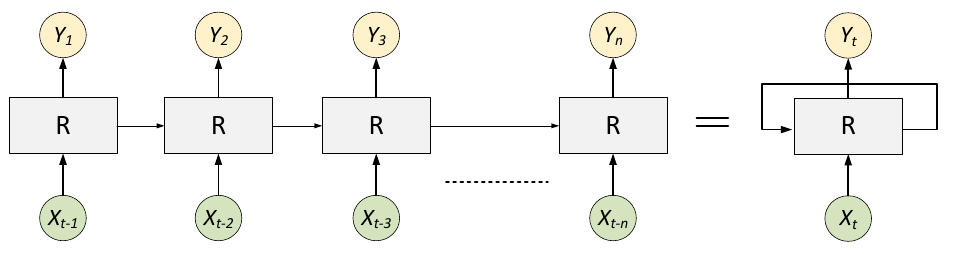
Figure 2. RNN architecture.